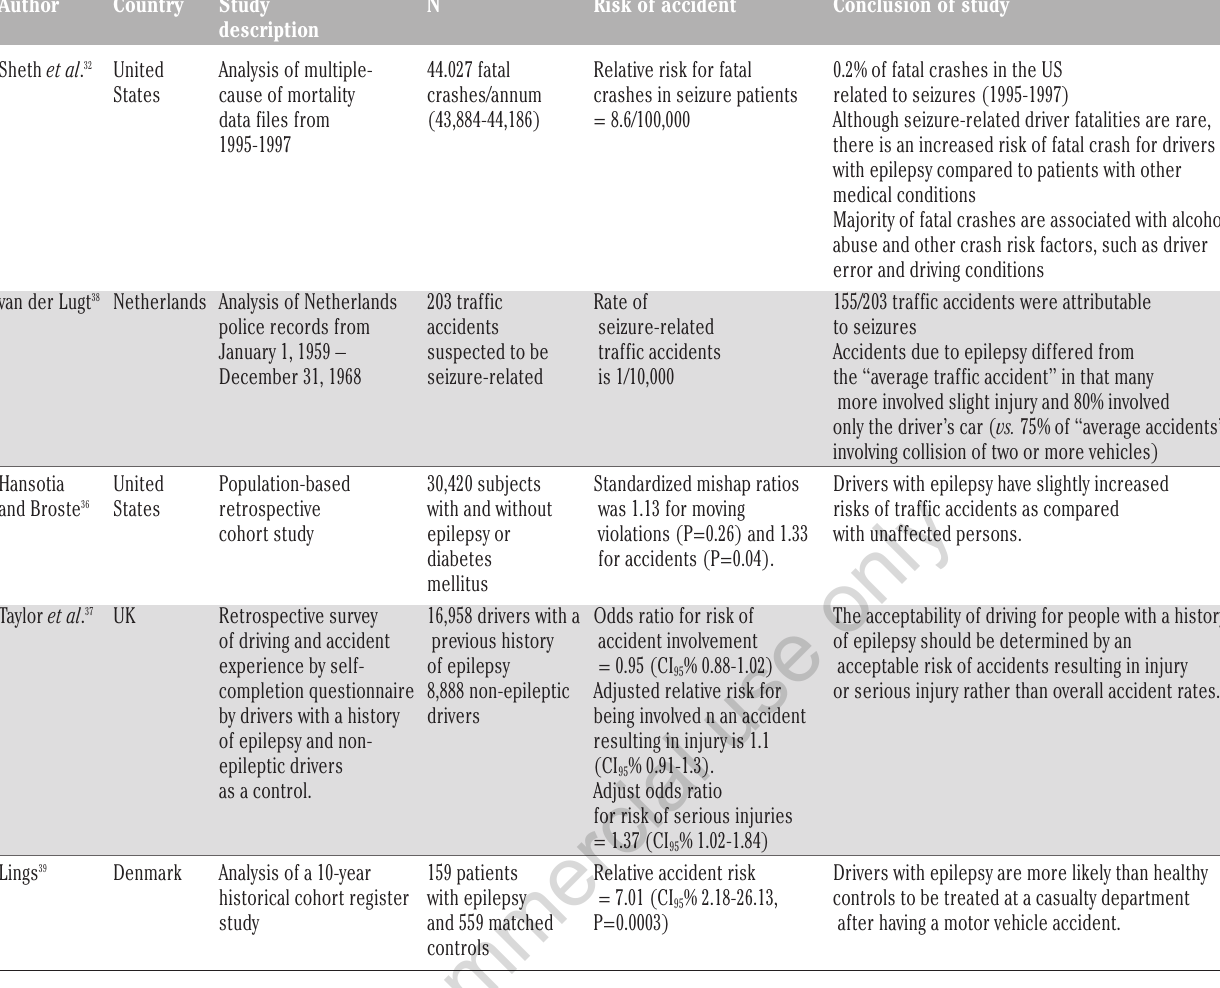
Table 2. Traffic accidents and